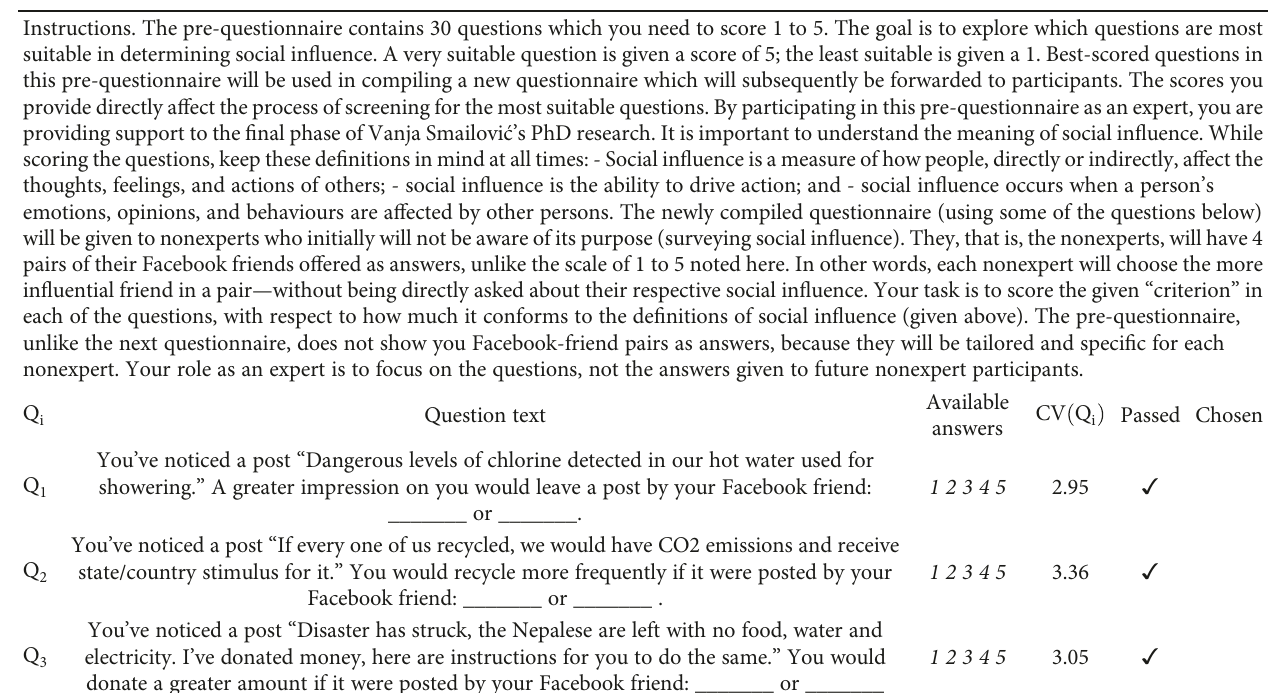
Table 5: Pre-questionnaire (content validity) given to